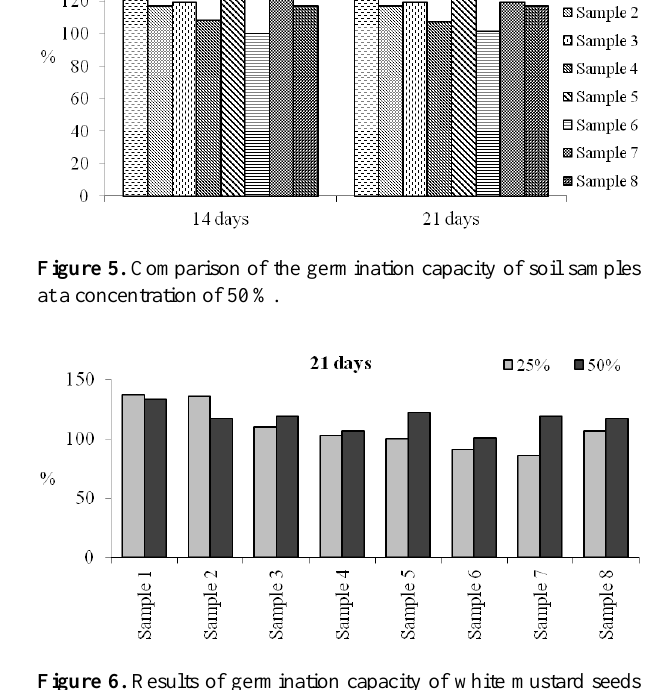
Figure 6. Results of germination capacity of white mustard seeds (at concentrations of 25 and